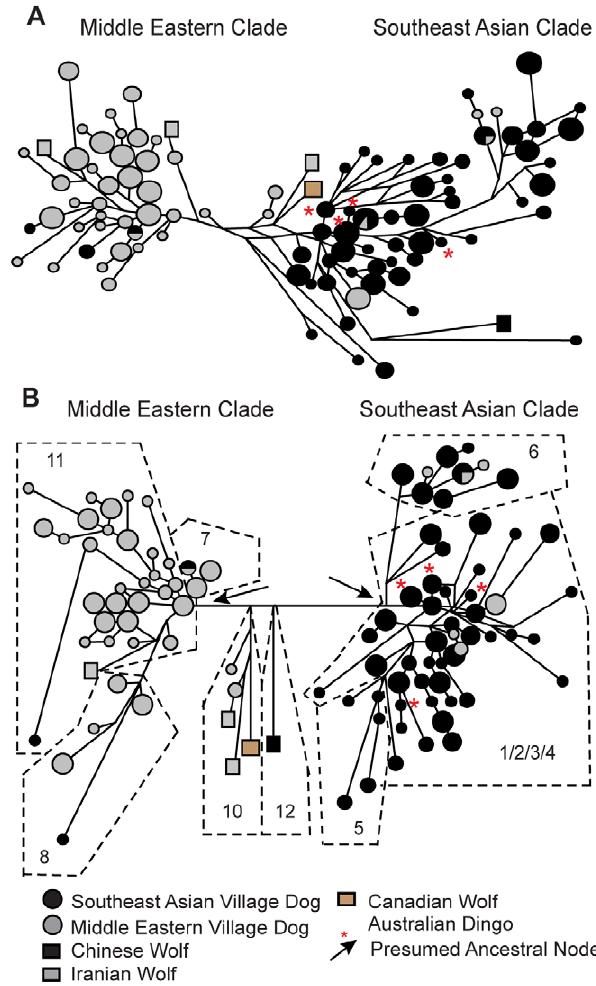
Figure 2. Village dog Y chromosome STR and SNP-STR haplotype networks. Networks of 300 village dog/dingo (circles) and 7 wolf (squares) (a) NRY STR haplotypes and (b) NRY SNP-STR haplotypes, including (a,b) 164 Southeast Asian village dogs/dingoes, 136 Middle Eastern village dogs, 1 Chinese wolf, 3 Iranian wolves, and 3 Canadian wolves. Size of circle is proportional to sample size, except that the largest circle represents 18–50 individuals, and line lengths are proportional to the number of mutational steps. (b) NRY SNP-STR subclades corresponding to numbered SNP haplotypes in Figure 1 are circumscribed by dashed black lines. doi:10.1371/journal.pone.0028496.g002 divergence between village dog populations and for comparing to the haplotypes of breed dogs to infer their proximate origins. Based on the dog haplotypes of the SNP-STR network (i.e., excluding wolves), each haplotype was rooted to its most proximate common ancestral node (arrows in Figure 2b) and the average number of mutational steps ( r ) to descendant nodes was estimated. These r estimates suggested a more recent origin of the Middle Eastern village dog clade ( r = 3.41 mutations, ‘‘95%’’ CI = 2.0–4.9) than the Southeast Asian Village dog clade ( r = 6.46 mutations, ‘‘95%’’ CI = 3.8–9.1). The r value associated with two clades unique to dogs on Bali was used to calibrate these values. Specifically, r = 2.0 (‘‘95%’’ CI = 0.41–3.59) was estimated for a subclade rooted to haplotype 0d (descendent nodes 0a, 0c, 0e, 0g, 0i, 0k, 1d) and r = 1.0 (‘‘95%’’ CI =0.12–1.88) for a subclade rooted to haplotype 0f (descendent nodes 0b, 0h, 0j; Tables S8,